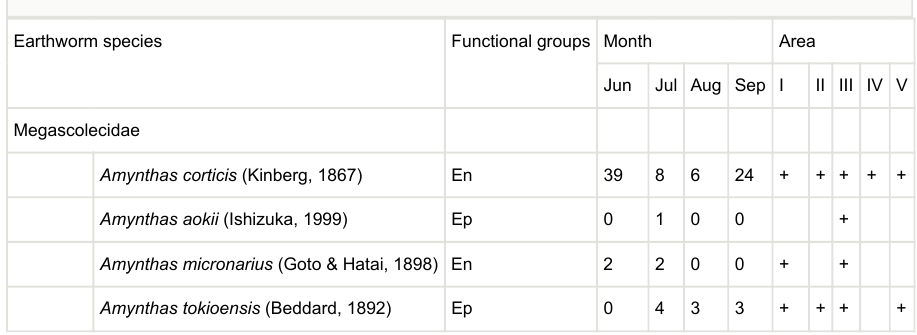
Functional groups, monthly individual numbers and regional occurrences of adult earthworm species. En: Endogeic species, Ep: Epigeic